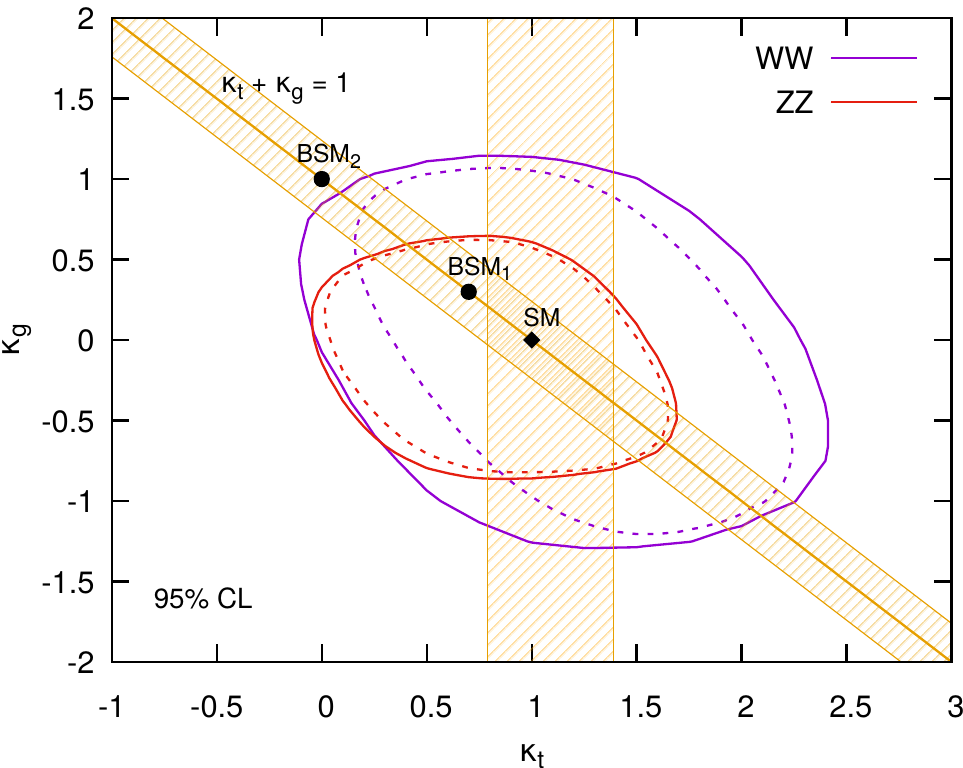
Figure 14 . Exclusion contours at 95% level for WW and ZZ production, corresponding to an optimistic reduction of theoretical uncertainties, see the main text for